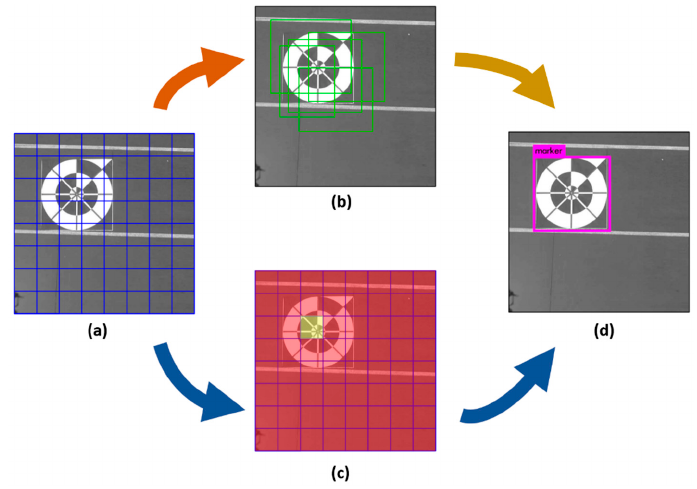
Figure 7. Example of YOLO v2 marker detection. ( a ) YOLO v2 divides the input image into S × S grid, and ( b ) each grid cell predicts five bounding boxes based on five prior anchor boxes. The predictions are stored in an S × S × ( 5 × ( 5 + C ) ) output tensor. This example shows how YOLO v2 predicts from an input image with a grid size S = 8 and C = 1 (number of classes to be detected) so that the size of the final output tensor is 8 × 8 × 30 ; ( c ) The yellow shaded cell shows higher potential of detecting marker compared to other red shaded cells; ( d ) The result of the detected marker.